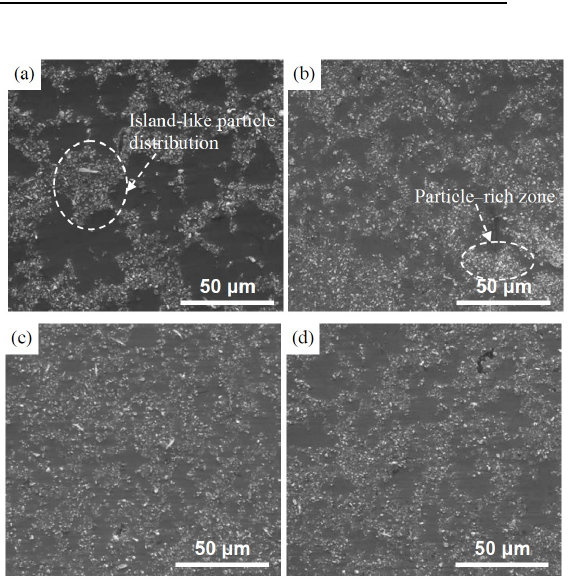
Figure 4: SEM graphs of SiCp/AZ31B composites fabricated by semi- solid stirring assisted ultrasonic vibration with different stirring time.